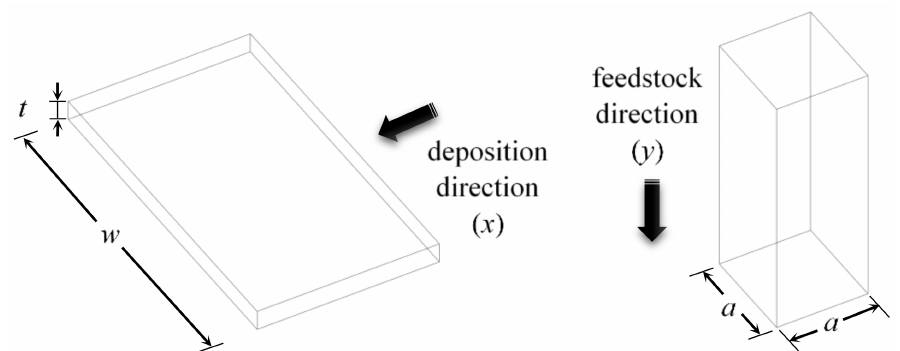
Figure 2. Schematic figure of feedstock rod and deposition plane; the feedstock (in our case, a 20-inch-long bar with 3/8-inch by 3/8-inch cross section) is pushed to the tool with a linear actuator. As the tool moves in traverse direction, it deposits the softened metal layer by layer. The integrity, width, and thickness of the deposited layer are dominated by the processing